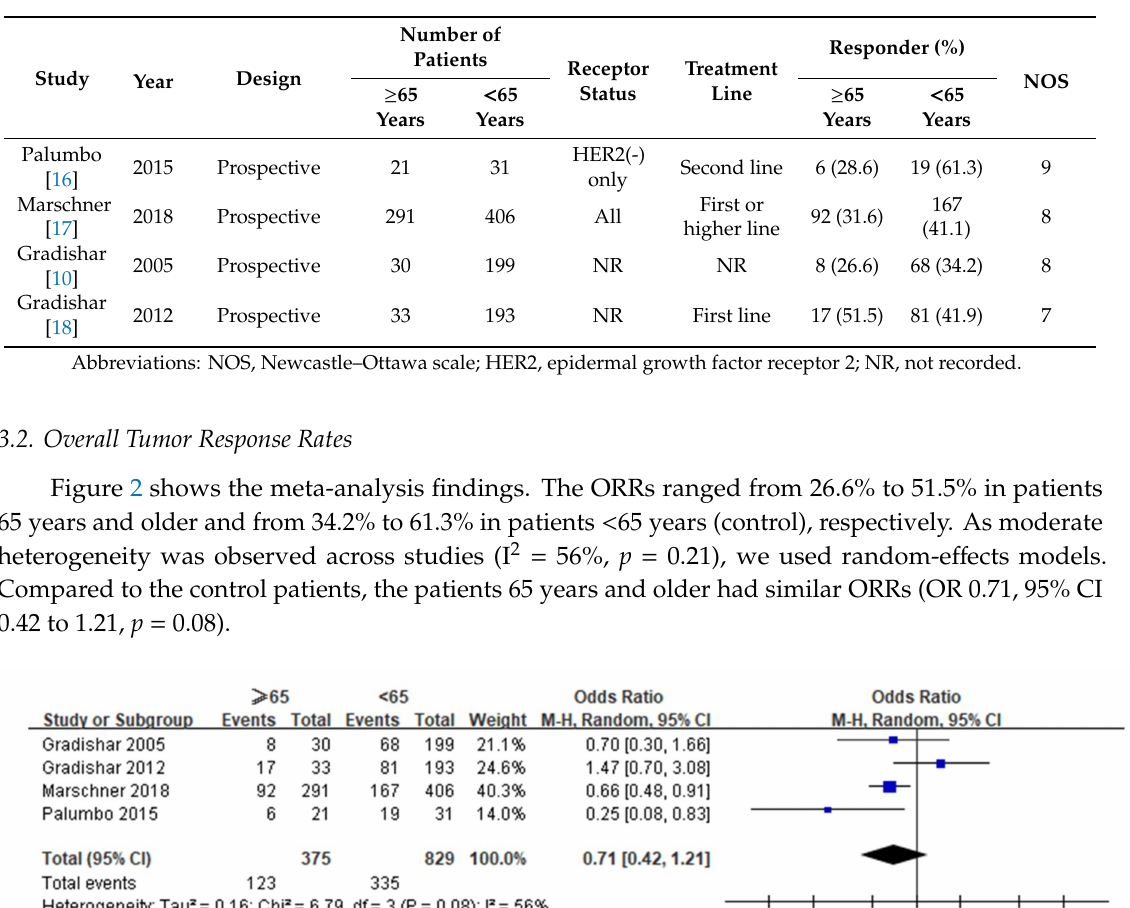
Table 1. Characteristics of the included studies.